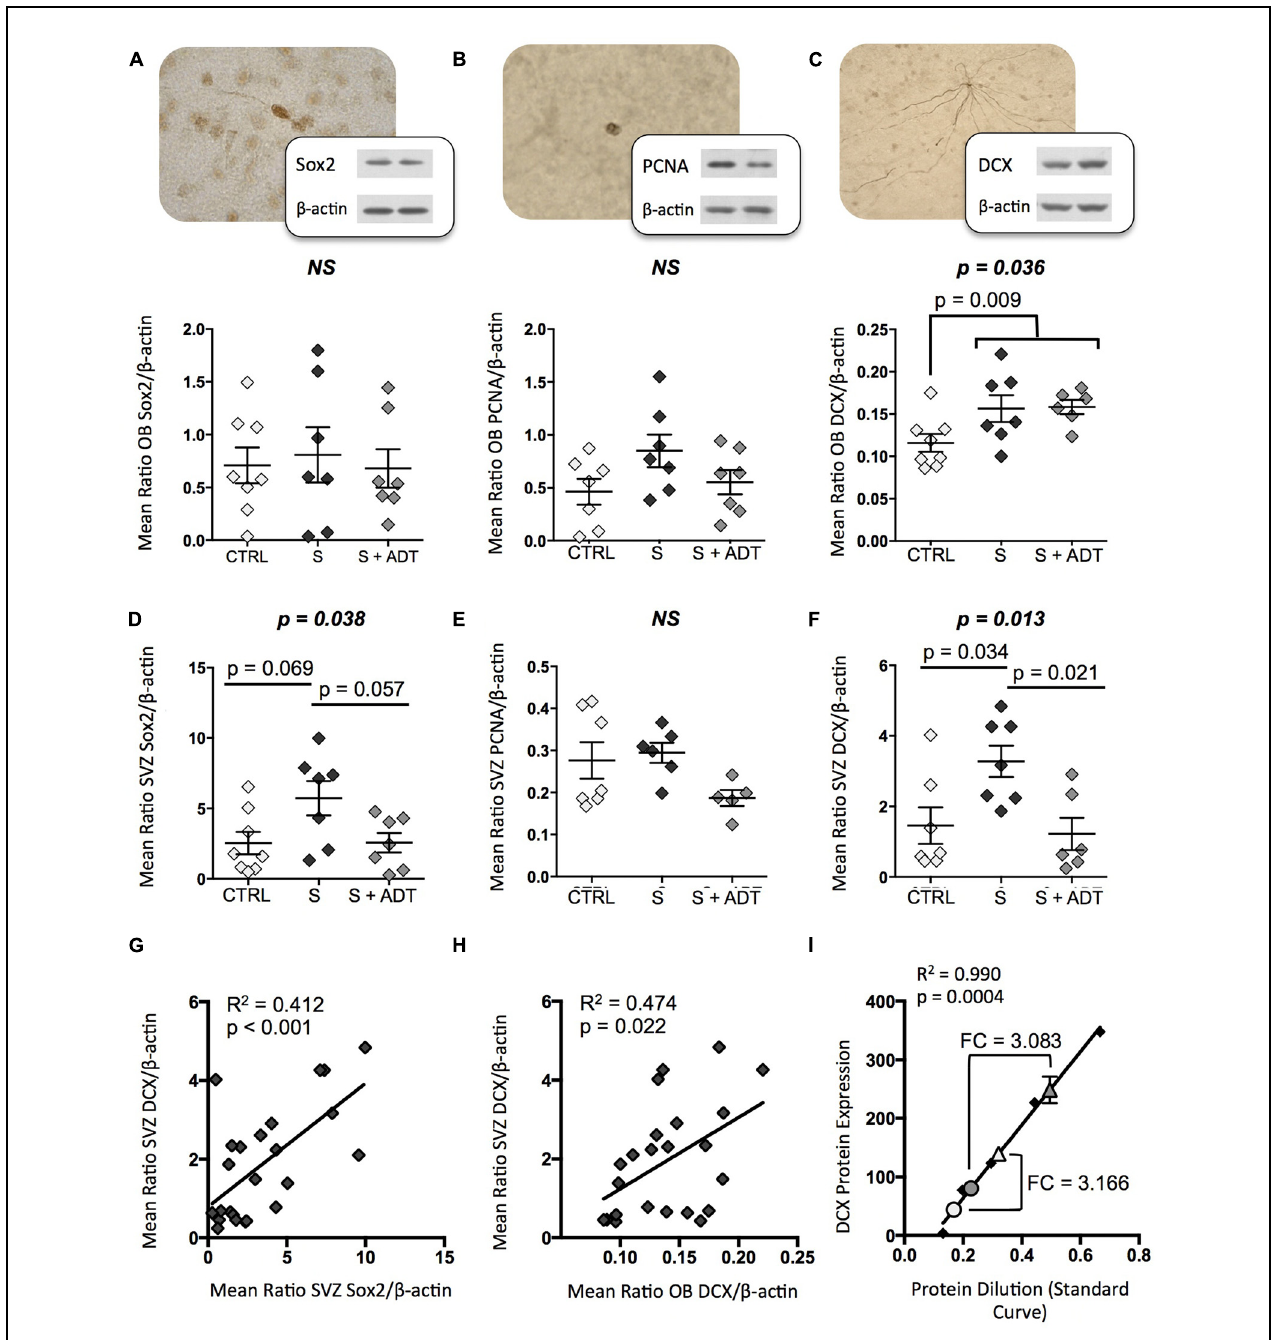
FIGURE 1 | Expression of neurogenic markers Sox2, proliferating cell nuclear antigen (PCNA), and doublecortin (DCX) in the olfactory bulb (OB) and subventricular zone (SVZ) of suicides (S; n = 7), antidepressant treated suicides (S + ADT; n = 7), and matched controls (CTRL; n = 8). (A,B) Medicated and unmedicated suicides did not differ from controls with regards to OB Sox2 expression or PCNA levels. (C) The S group displayed significantly higher DCX expression than did CTRLs ( p = 0.009). (D) ADT did not reverse the increased DCX expression observed in the OB of S subjects. In the SVZ, although groups did not differ with regards to PCNA expression, unmedicated suicides displayed a tendency toward higher Sox2 levels than